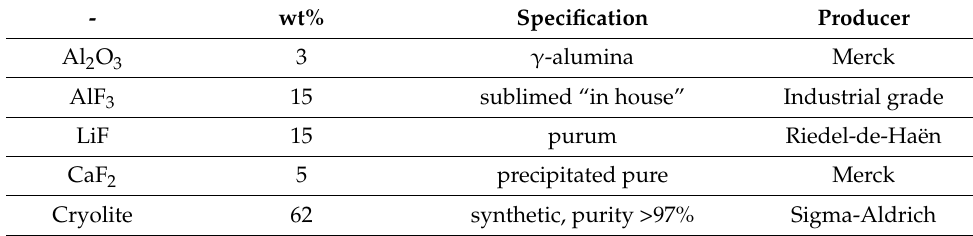
Table 1. Cryolite bath